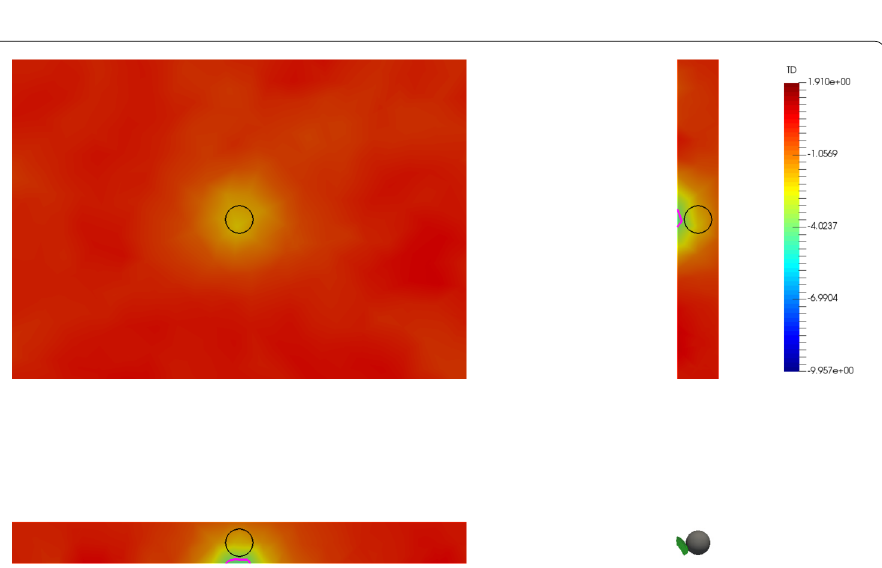
Figure 18 Reconstruction of the spherical defect. Upper left: Topological derivative at x = 0. Upper right: Topological derivative at y = –0.125. Lower left: Topological derivative at z = 0. Lower right: Perspective showing the reconstruction for λ = 0.4 and the original